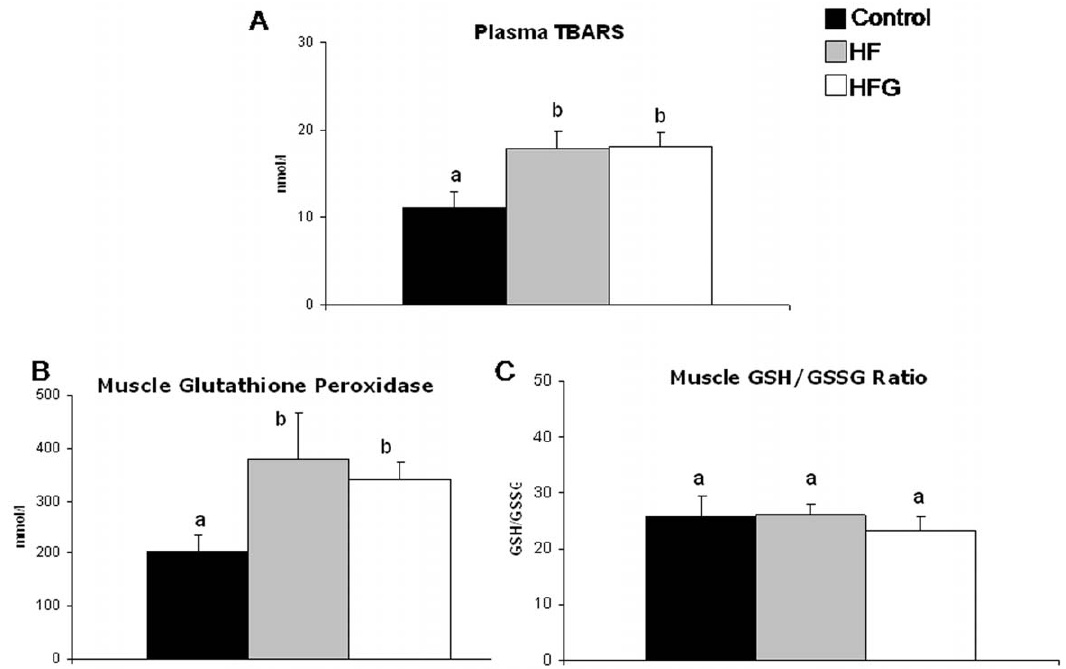
Figure 3. Acylated ghrelin effects are independent of changes in gastrocnemius muscle redox state. Effects of one-month high-fat feeding without (HF) or with (HFG) 4-day acylated ghrelin treatment on plasma TBARS concentration (a) and on gastrocnemius muscle glutathione peroxidase activity (b), and total 1 oxidized glutathione ratio (c). Different letters denote statistically significant differences (P , 0.05 ANOVA and post- hoc test).